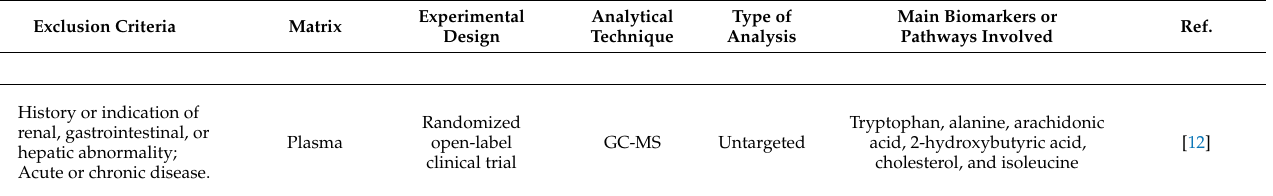
Table 1. Summary of the main metabolomic studies on the effects of lipid-lowering